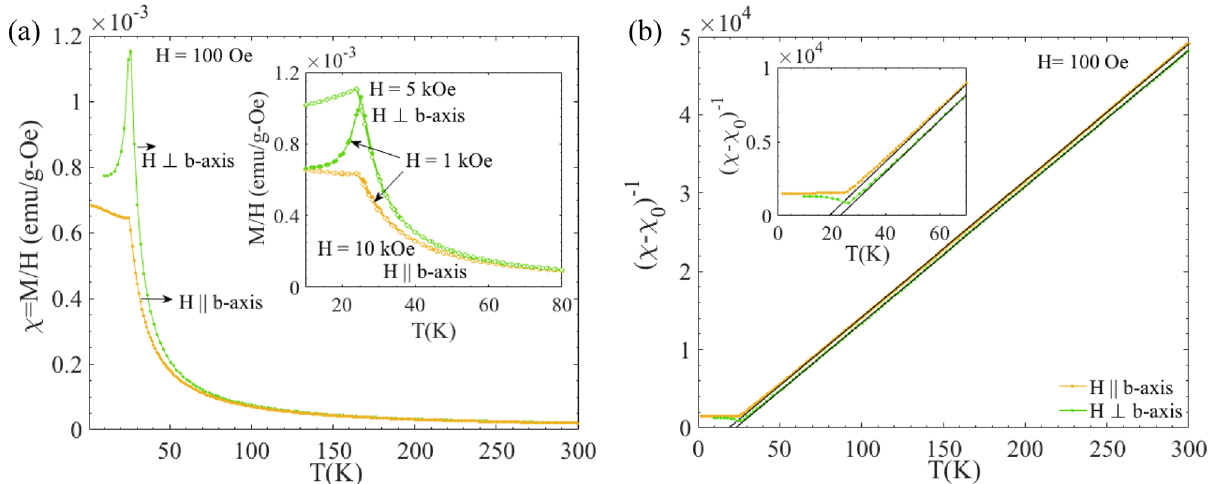
Figure 6. ( a ) Temperature dependence of magnetic susceptibility χ (T) of GdAu 6.75−x Al 0.5+x measured after ZFC with H = 100 Oe along H ⊥ b -axis (green color) and H ∥ b -axis (yellow color). The inset shows the χ (T) curve recorded after ZFC and FC at relatively higher magnetic fields for both orientations. ( b ) Curie–Weiss plots using temperature dependence of the inverse magnetic susceptibility for both orientations, where χ 0 is the background correction term. The black solid lines are the best fits of ( χ − χ 0 ) −1 (T) to the Curie–Weiss equation. Inset shows the zoomed view of the main panel.